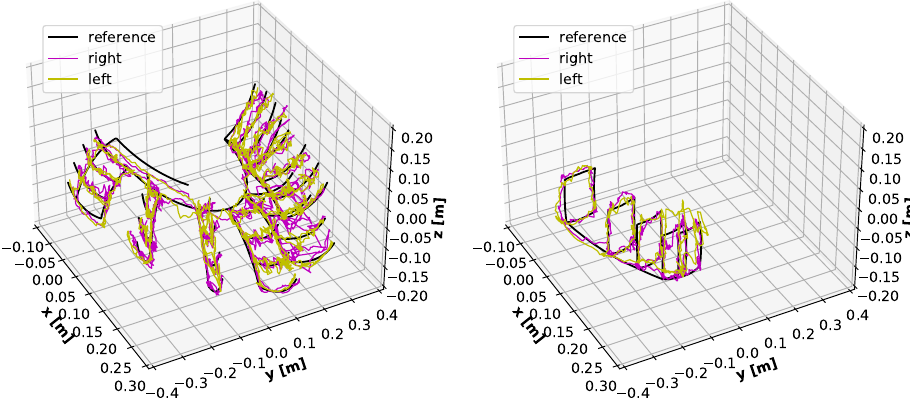
Figure 16. Trajectories in Cartesian space for the graph fitting model. Black: set trajectory; colours: predictions from the left (yellow) and the right (magenta)